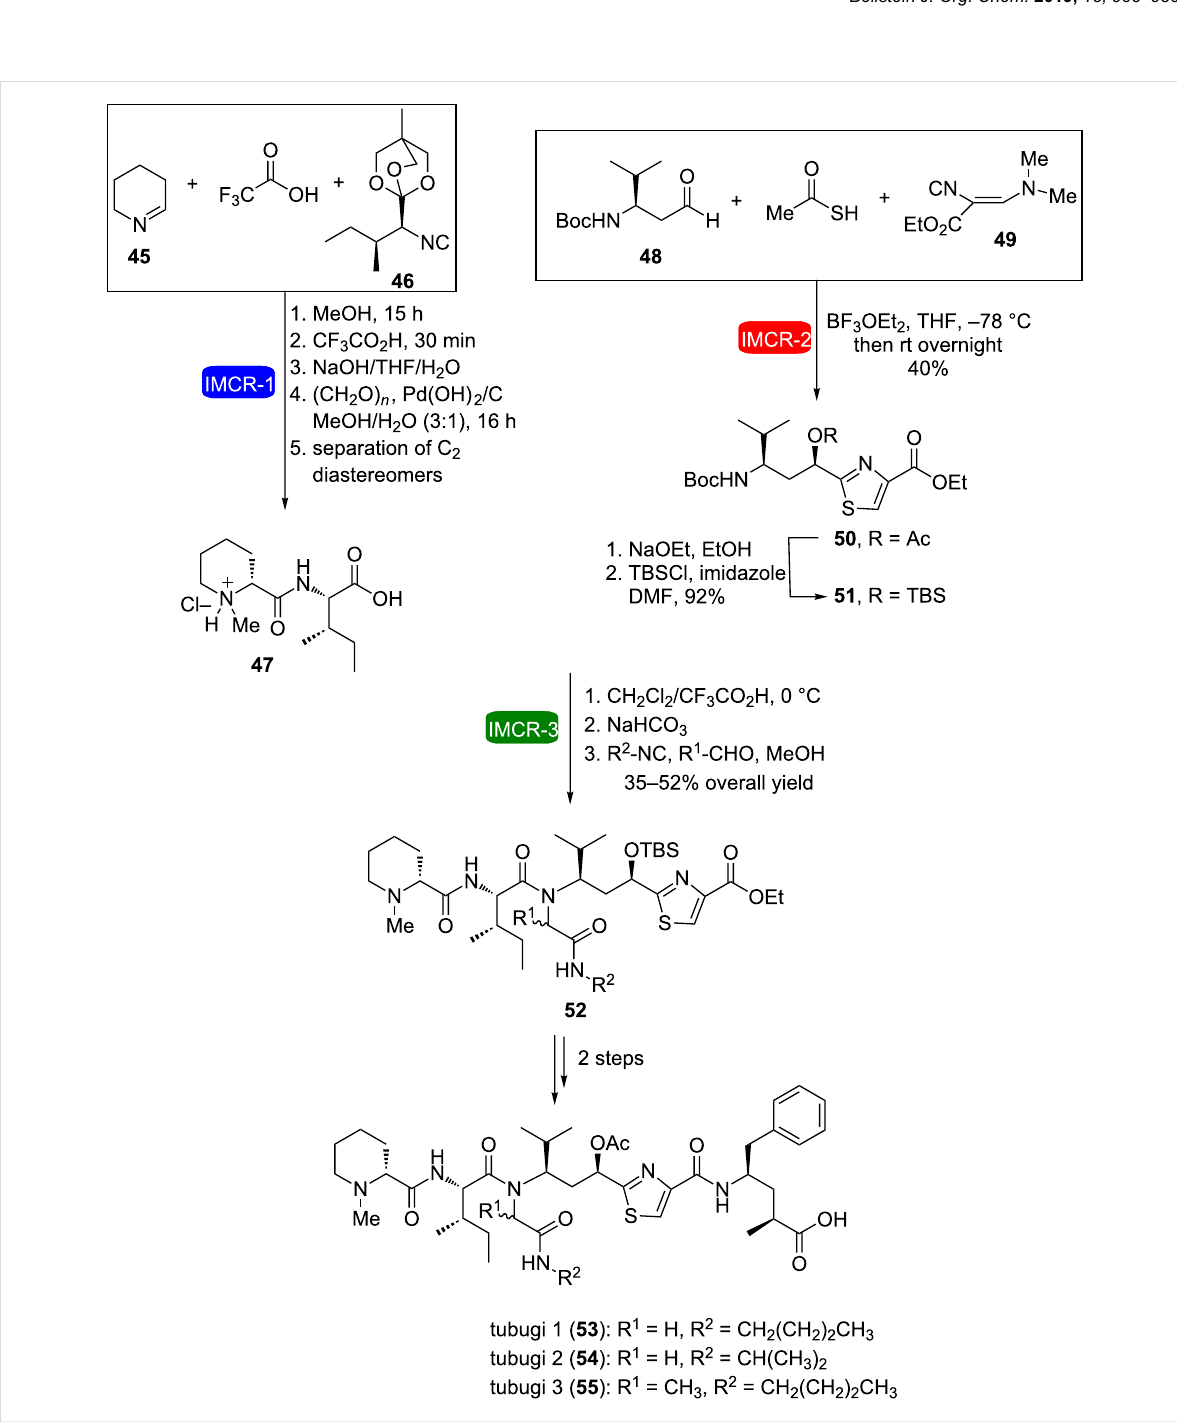
Scheme 11: Synthesis of tubugis via three consecutive IMCRs